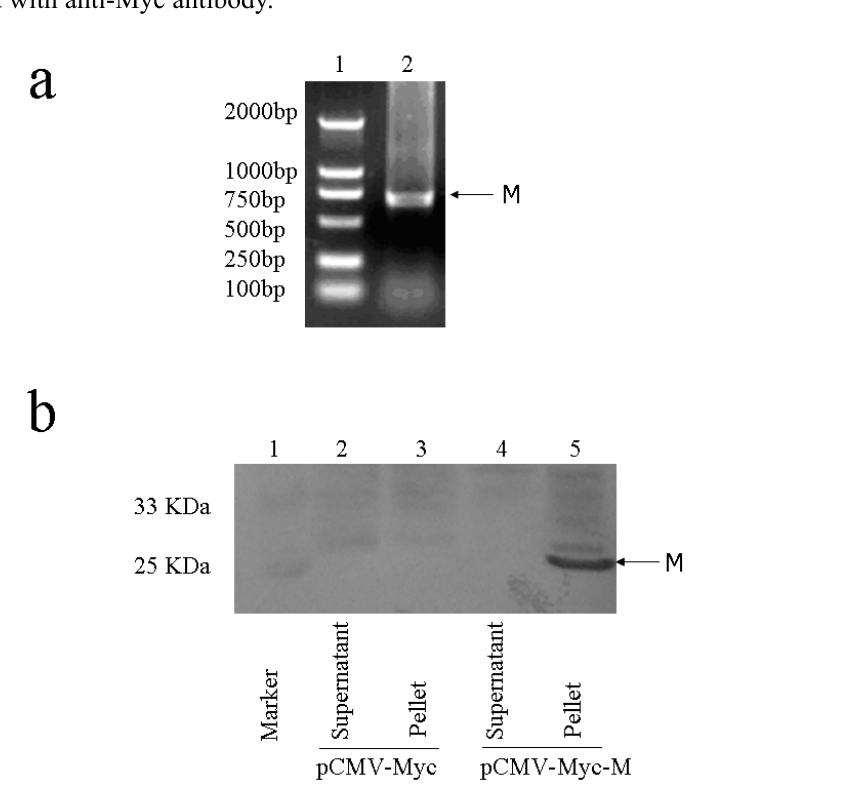
Figure 2. Cloning and expression analysis of SARS-CoV M gene. (a) M gene was cloned by RT-PCR. (b) Western blot analysis on M gene expression in HEK293T cells. HEK293T cells were transfected with either pCMV-Myc or pCMV-Myc-M. After 48 h, the transfected cells were lysed and subjected to brief centrifugation to separate supernatant from cell pellet. Equal amount of cell supernatant and pellet were resolved onto 12% SDS-PAGE. The reaction products were probed with anti-Myc